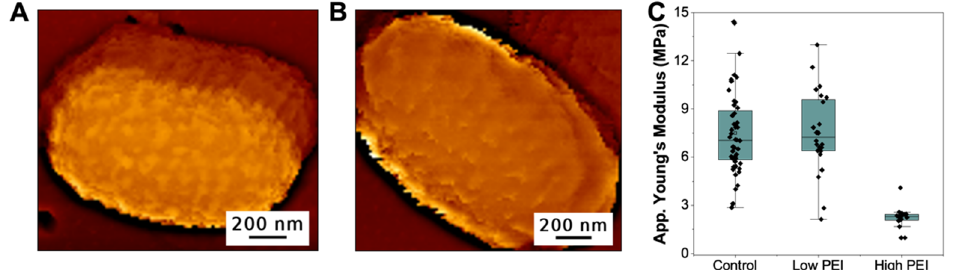
Figure 2. Topography images of E. coli pre-treated with ( A ) 4 µ g/mL ( n = 24) and ( B ) 100 µ g/mL ( n = 18) unbound PEI. ( C ) The distribution of the average apparent Young’s modulus of PEI-treated bacteria (low PEI = 4 µ g/mL and high PEI = 100 µ g/mL unbound PEI) relative to the untreated bacteria (control).